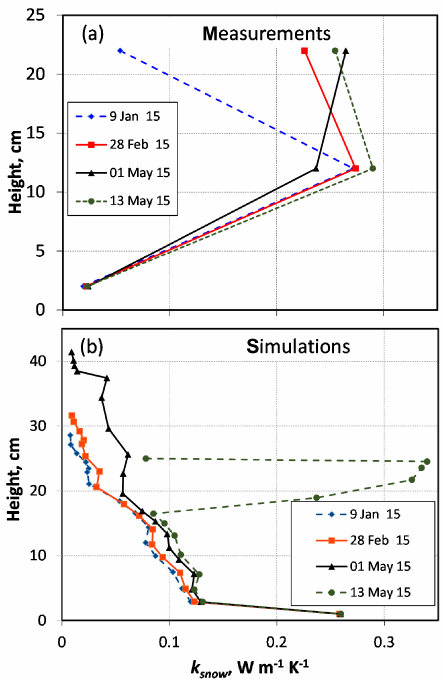
Figure 13. Vertical profiles of k snow : (a) measured by the needle probes; (b) modelled by